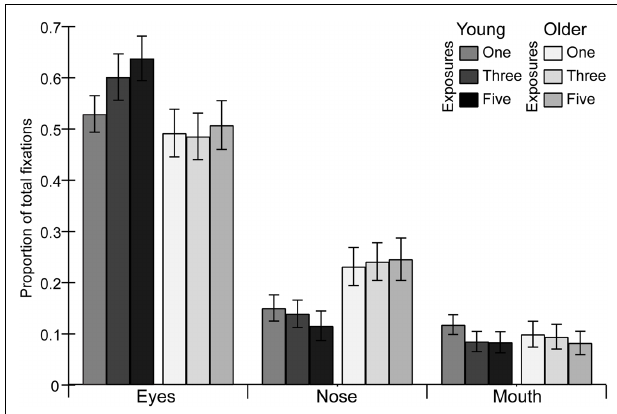
FIGURE 4 |The proportion of fixations made to the eyes, nose, and mouth of faces by young and older adults as a function of prior exposure. Error bars represent SE of the mean corrected for repeated measures specific to the within-subject contrasts (see Masson and Loftus,